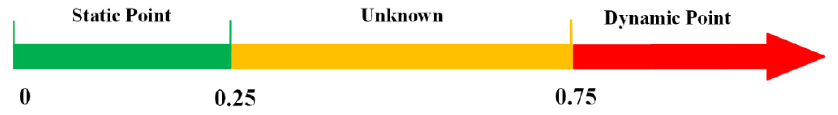
Figure 4. Correspondence between dynamic states of map points and dynamic probabilities. in_view M